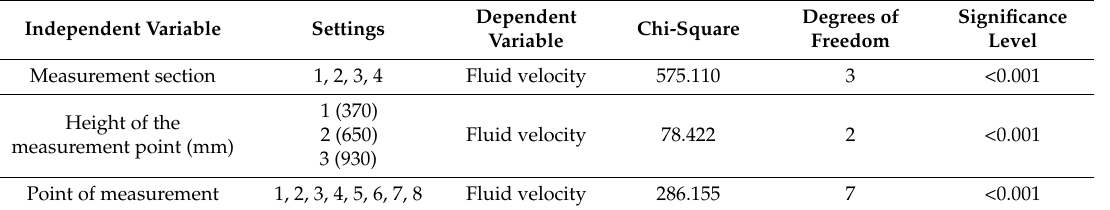
Table 5. Kruskal-Wallis test. Effect of the variables related to the position of the measurement point (section, height, measurement point) on the fluid velocity.